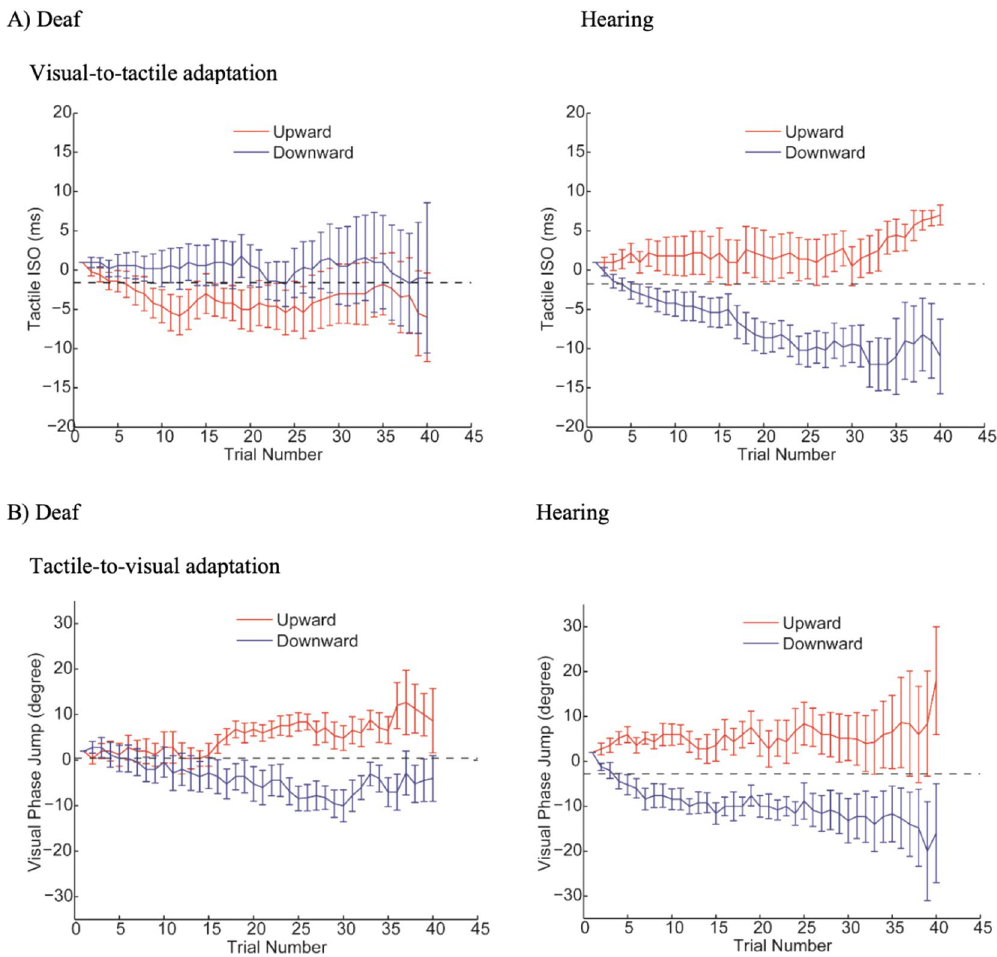
Figure 6. Staircase progress in Experiment 1. The staircase progress is shown separately for the deaf (left column) and hearing participants (right column) in the visual-to-tactile (panel A ) and tactile-to-visual (panel B ) adaptation conditions. Staircases in the upward and downward adaptation conditions are shown respectively in red and blue. The black dashed lines were the average baseline PSE without adaptation. Error bars represent one standard